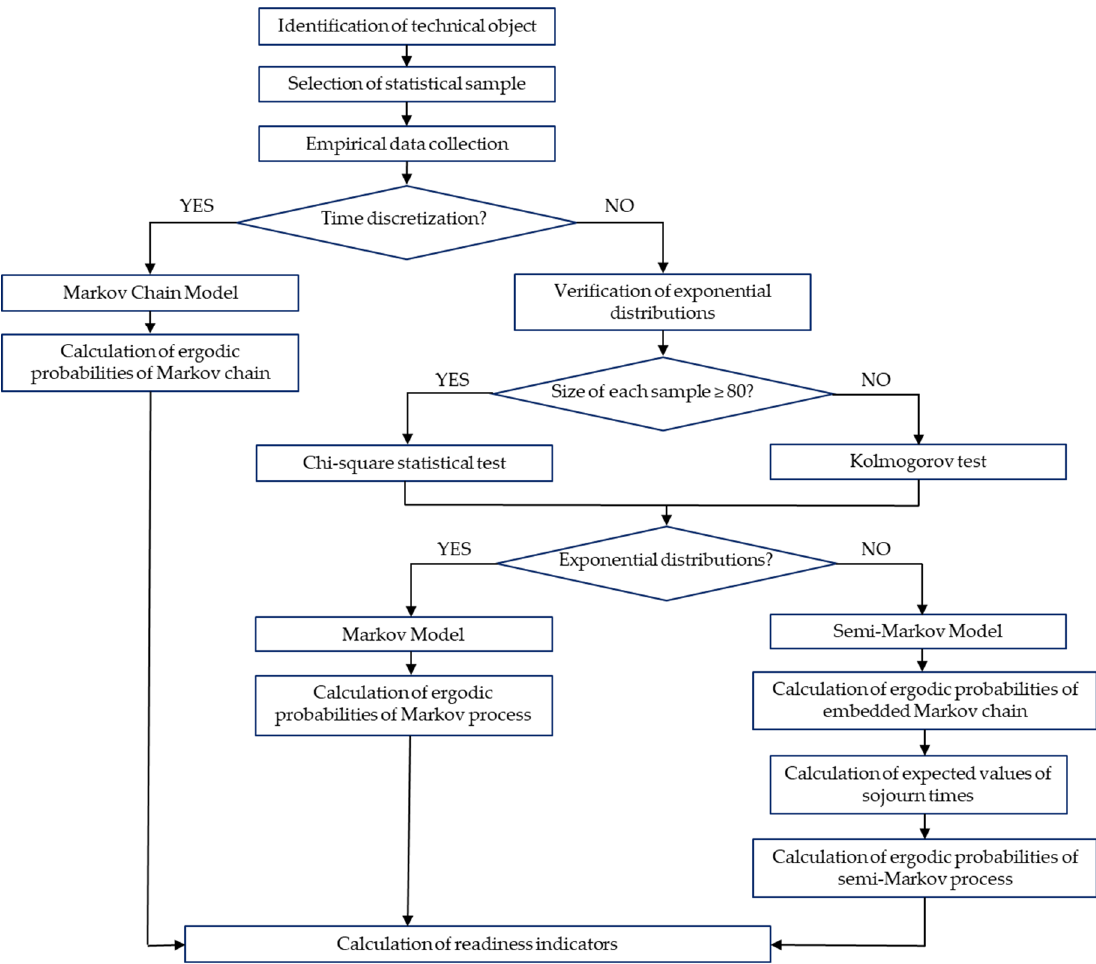
Figure 1. Flowchart of stochastic modeling.